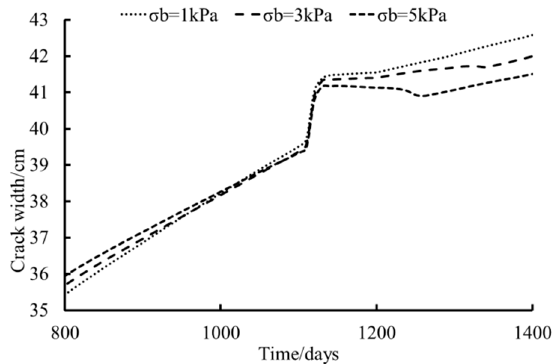
Figure 19. Crack-width–time curve under different tensile strength conditions.